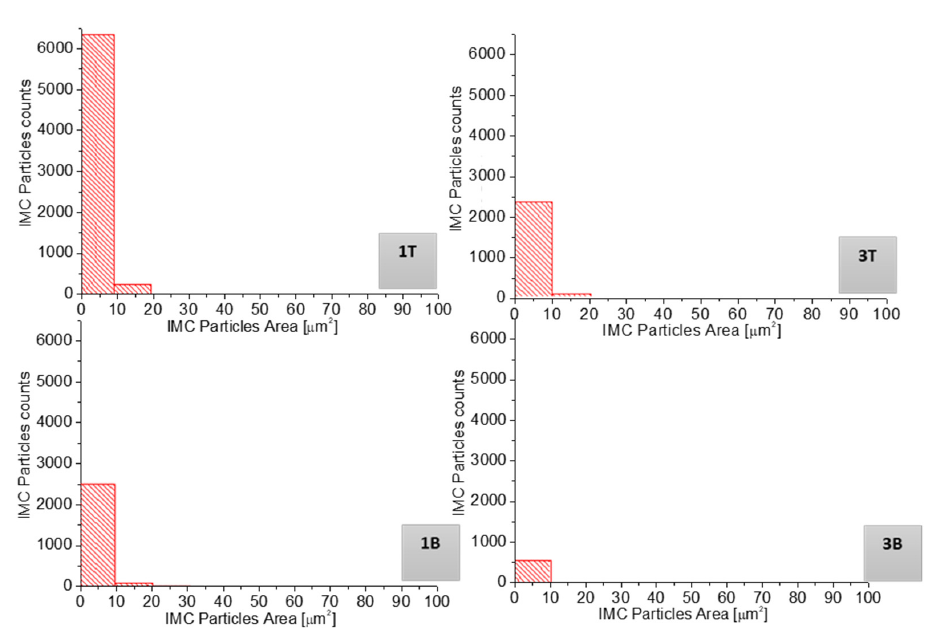
Figure 8. Distribution of IMC particles as function of particles area in 1T, 1B, 3T and 3B